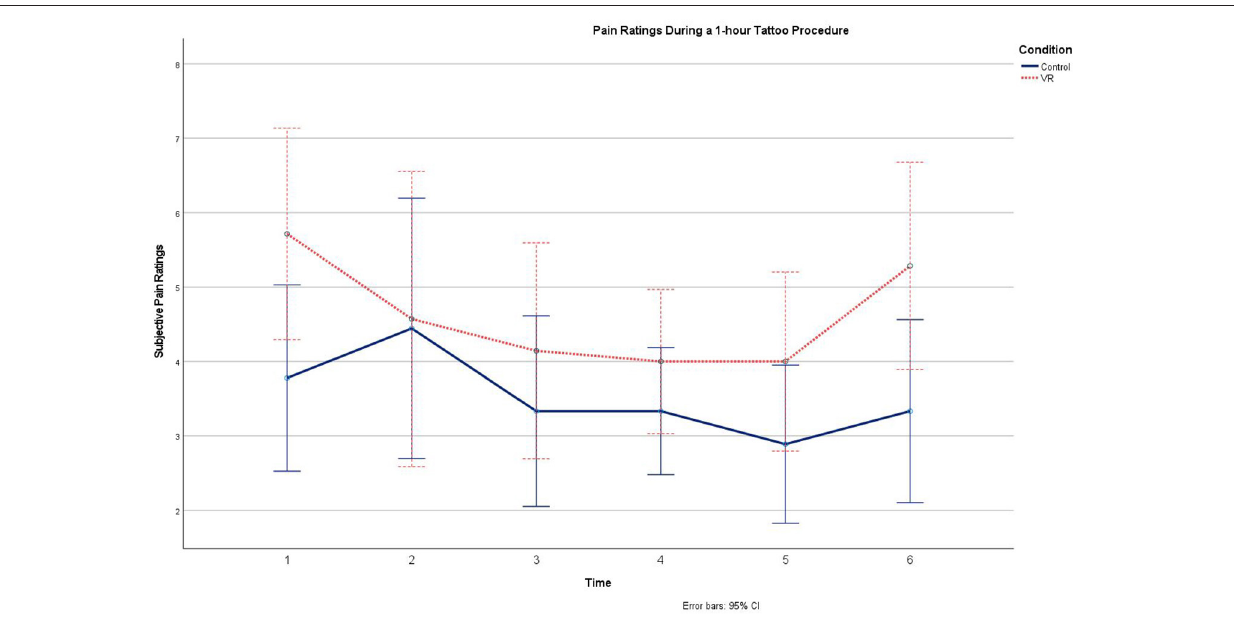
whereas pain ratings increased during the same time frame for those in the control group ( M Difference = -.66, SD = 1.8). t (14) =